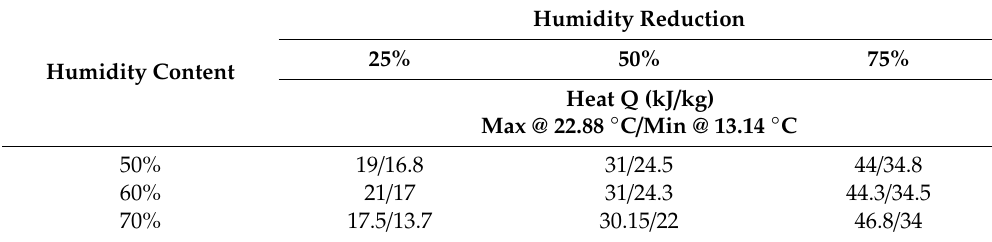
Table 1. Maximum values, minimum heat required to extract with respect to relative